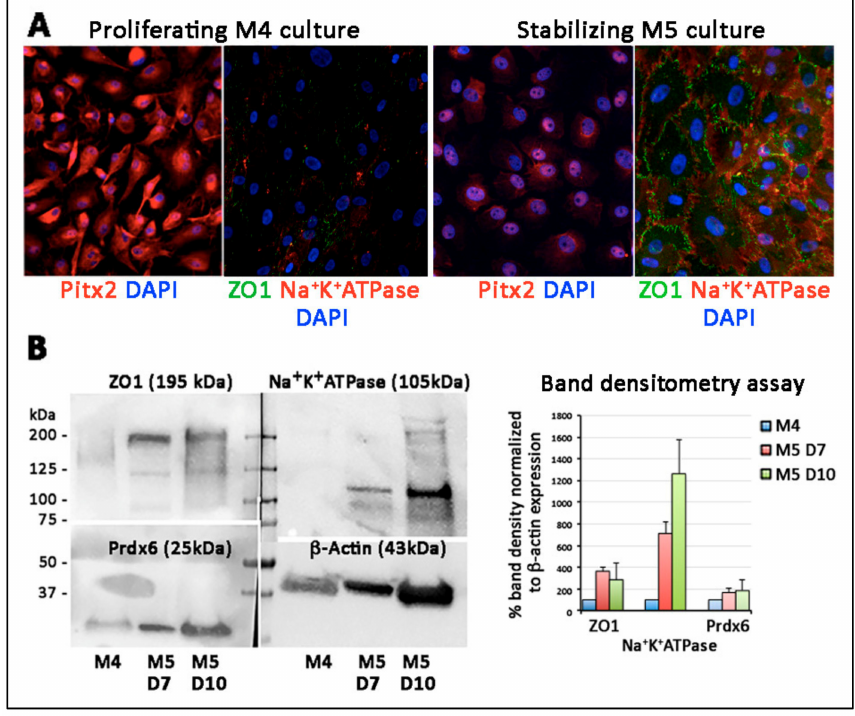
Figure 9. Characterization of porcine transition zone (TZ)-generated endothelial-like cells. ( A ) Immunostaining of POM marker (Pitx2) and corneal endothelial di ff erentiation markers (ZO1, Na + K + ATPase) in M4 proliferative and M5 stabilization cultures. The expression of ZO1 and Na + K + ATPase was detected in M5 cultured cells, which had reduced Pitx2 expression. ( B ) Western blotting of ZO1, Na + K + ATPase and Prdx6. The nitrocellulose blot was cut with reference to the molecular weight range for primary antibody incubation and direct comparison of marker expression. Band densitometry analysis after normalization of β -actin expression showed elevated ZO1 and Na + K + ATPase expression under M5 stabilization culture for 7 and 10 days,